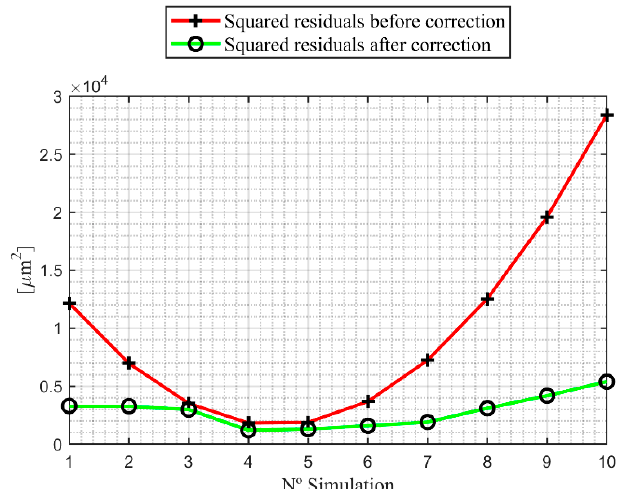
Figure 19. Comparison of the squared residuals before correction and after correction.